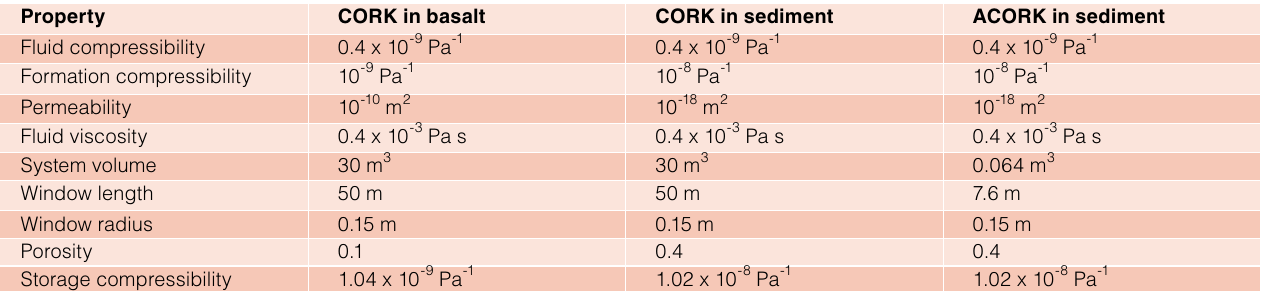
Table 1. Range of parameters for formation and CORK system properties (500 m hole assumed)